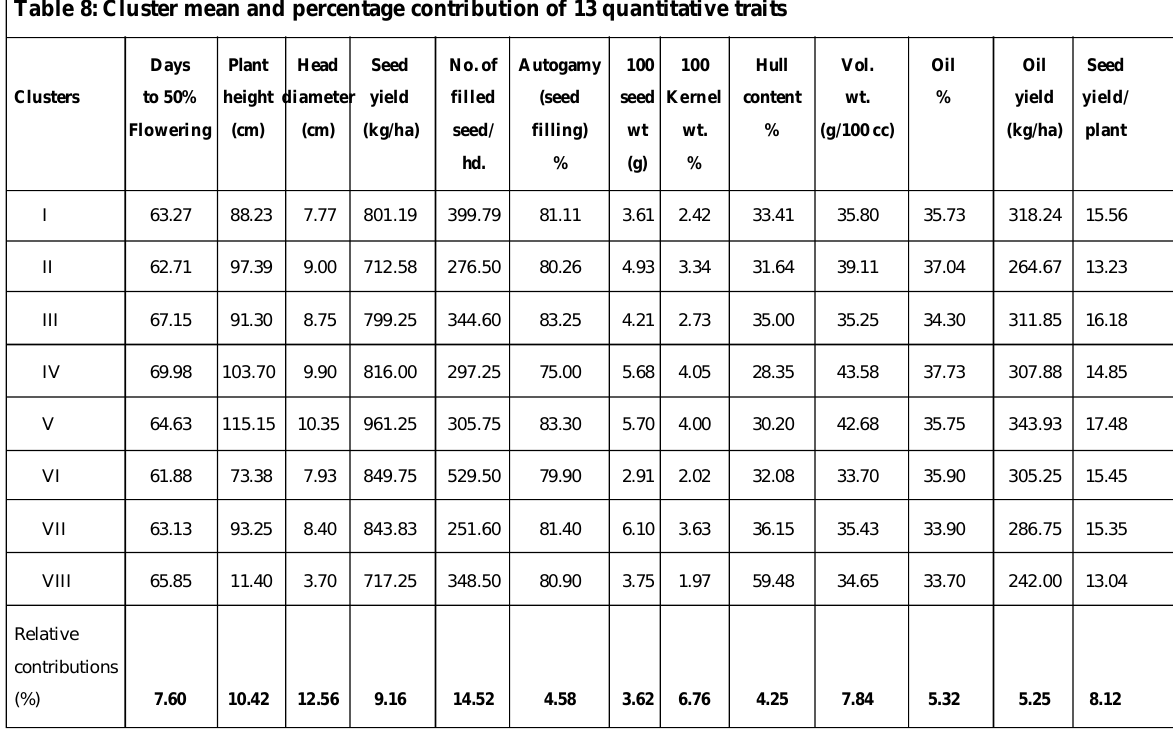
63.13 93.25 843.83 251.60 81.40 65.85 11.40 717.25 242.00 13.04 Relative contributions (%) 7.60 10.42 Cluster VII: It exhibited highest mean value for days to 50% flowering, plant height and seed yield but lowest seed filling% and lowest no. of filled grain/head. Cluster VIII: This cluster constituted highest mean value for days to 50% flowering, plant height and seed